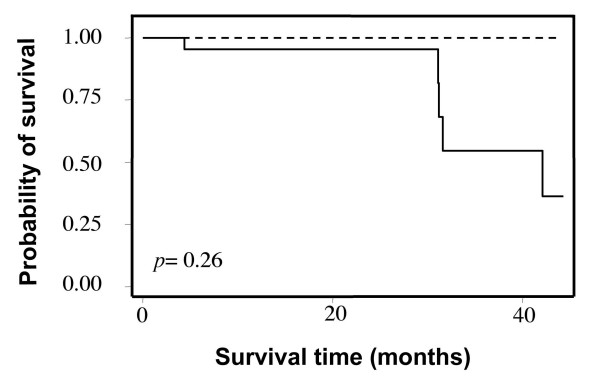
Kaplan/Meier survival analysis of cases by Smac expression. Continue black line: Negative expression. Dotted line: Positive expression. Insert in the lower left corner of plot is the P value testing the significance of the difference in the survival curves by the Mantel/Cox log rank test